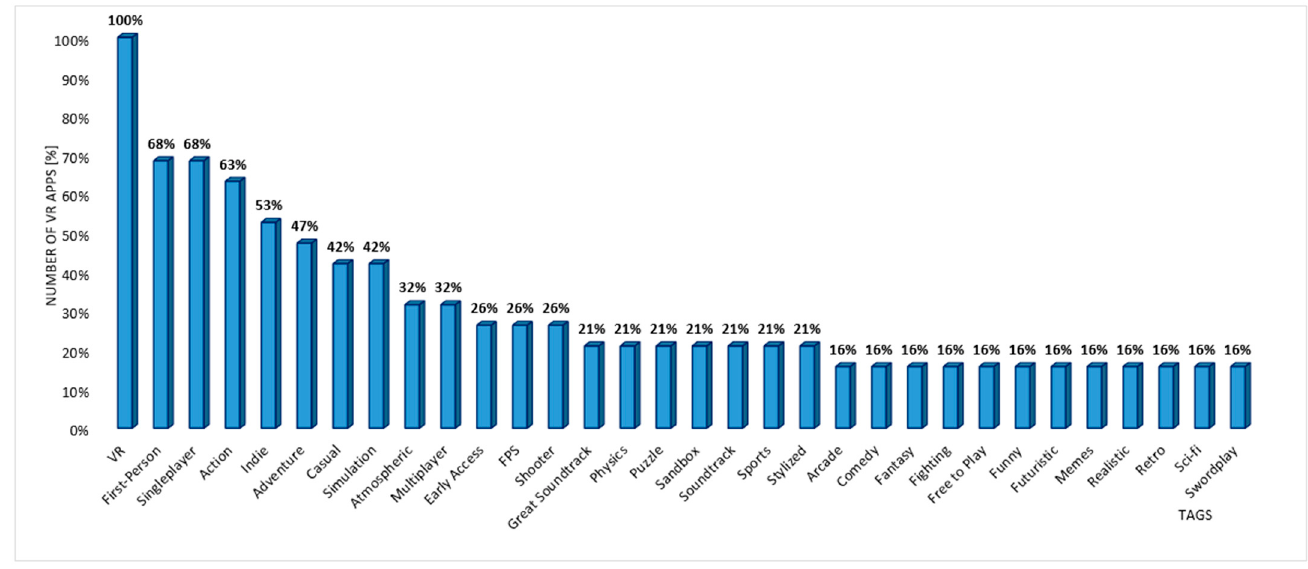
Figure 5. The number of VR applications with a given tag (results for tags that appeared in more than 15% of VR applications) of the 19 top-rated VR applications on Steam (author’s own study based on data from [35]) [state on 6 July 2022].